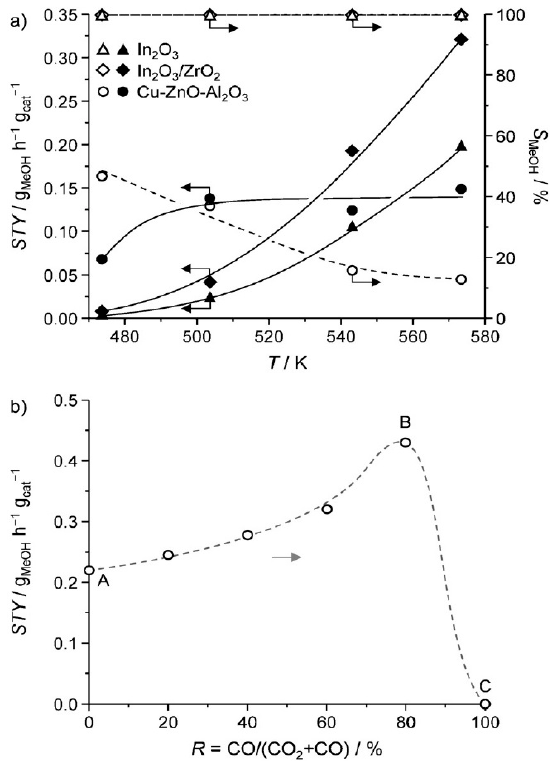
Figure 6. ( a ) Methanol STY and selectivity for CO 2 hydrogenation over bulk In 2 O 3 , In 2 O 3 /ZrO 2 (9 wt% In), and the benchmark Cu-ZnO-Al 2 O 3 catalyst at various temperatures. ( b ) Methanol STY over bulk In 2 O 3 as a function of the CO concentration in the feed at 573 K. Reaction conditions: p = 5.0 MPa, H 2 /CO 2 = 4:1, and GHSV = 16,000 h − 1 . Reprinted with permission from [79]. Copyright 2016